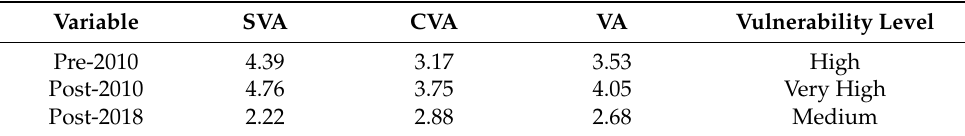
Table 16. Summary of the VA